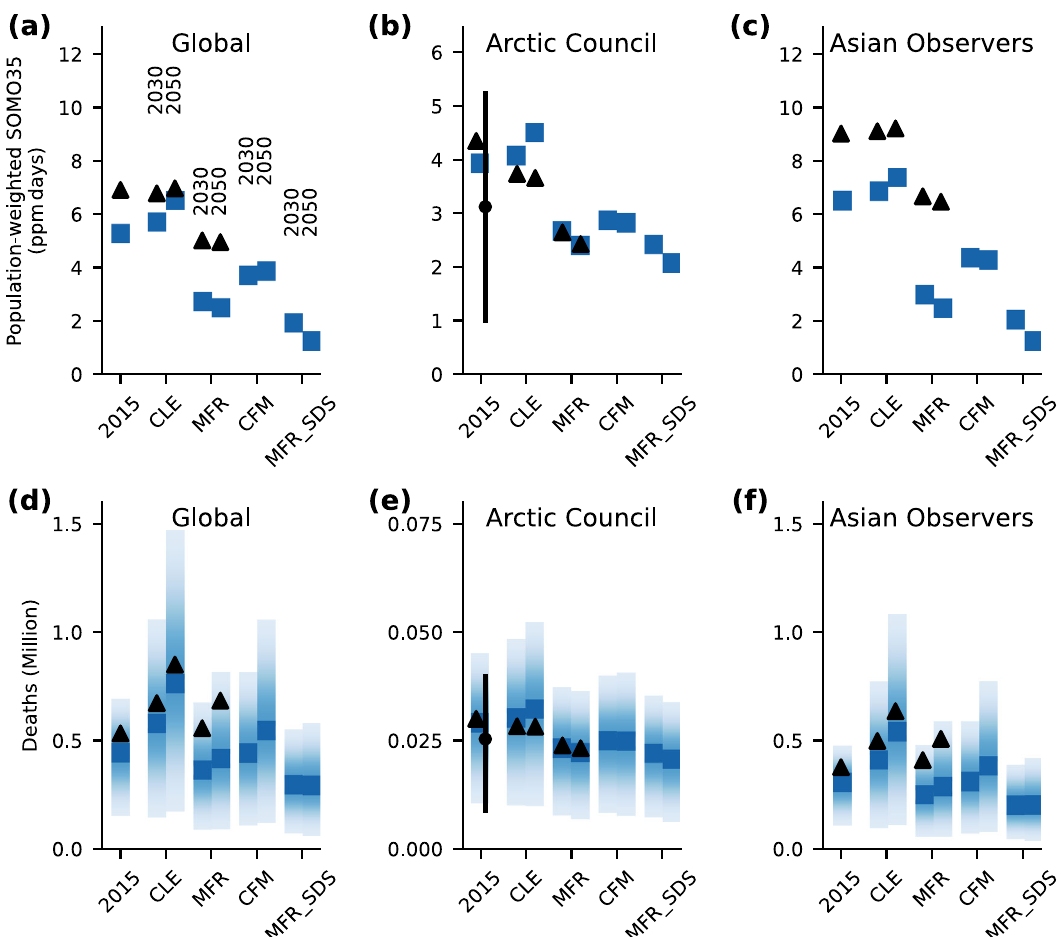
Fig. 5 Impact of ozone on human health. a – c show population-weighted Sum of Ozone Means Over 35 ppb (SOMO35) in three different regions, de fi ned as the yearly sum of the daily maximum of 8-hour running average ozone abundance over 35 ppb (World Health Organization air quality standard), based on simulations with the TM5-FASST model (blue squares). For the Arctic Council, black bullets refer to 2015 multi-model mean results from simulations with 4 global Earth System Models (ESMs) and Chemistry Transport Models (CTMs, Supplementary Notes 5, 6). In addition, results from the EMEP- MSCW model are available for the CLE and MFR scenarios (black triangles). d – f show the corresponding deaths in the same regions, based on simulations with TM5-FASST (blue squares). Con fi dence intervals (error bars) are indicated by black vertical lines in b , e , and blue shading in d – f . Additional mortality estimates from simulations with ESMs and CTMs are